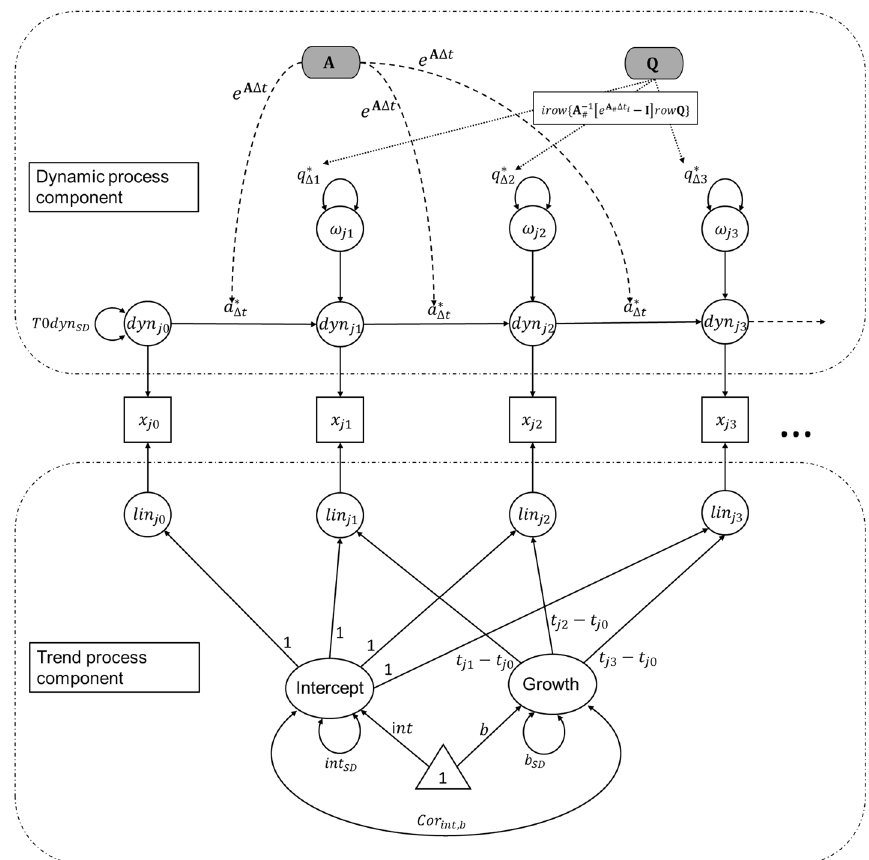
Fig. 2 Continuous-time Latent Curve Model with Structured Residuals . The CT-LCM-SR with four measurement occasions: Manifest scores x jt are represented by the squares. On the bottom of the squares, there is the trend process (standard linear growth-curve process with random effects for intercept and slope) accounting for differences in the initial values and trends. The continuous-time dynamic process, which accounts for the dynamic structure is represented on the top of the squares. Estimated parameters: int mean intercept, int SD variance of the random effects of the intercept, b mean growth rate, b SD SD of the random effects of the growth rate, Cor int , b intercept-growth correlation, T 0 dyn SD initial SD of the dynamic process; A drift matrix, Q diffusion